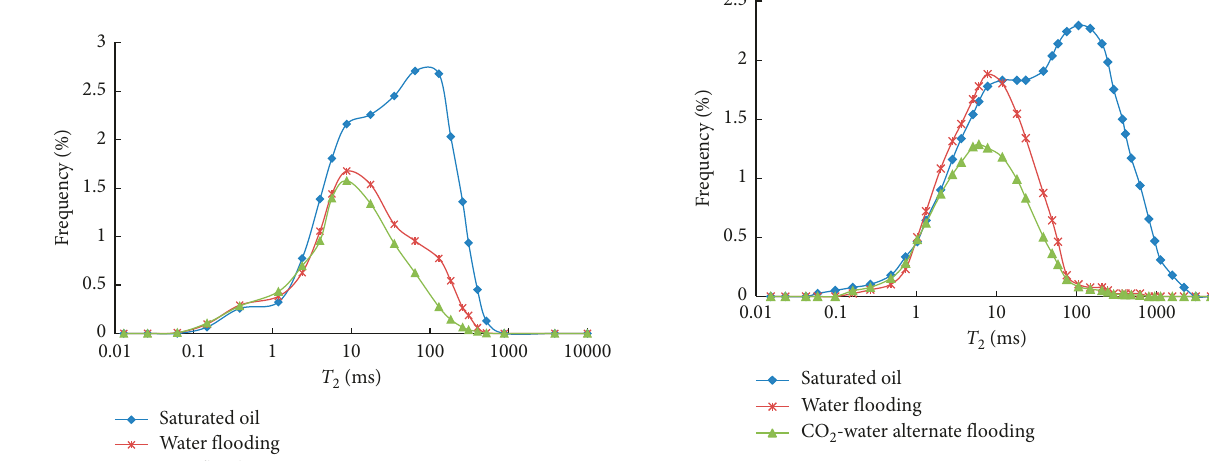
2 during CO 2 -water